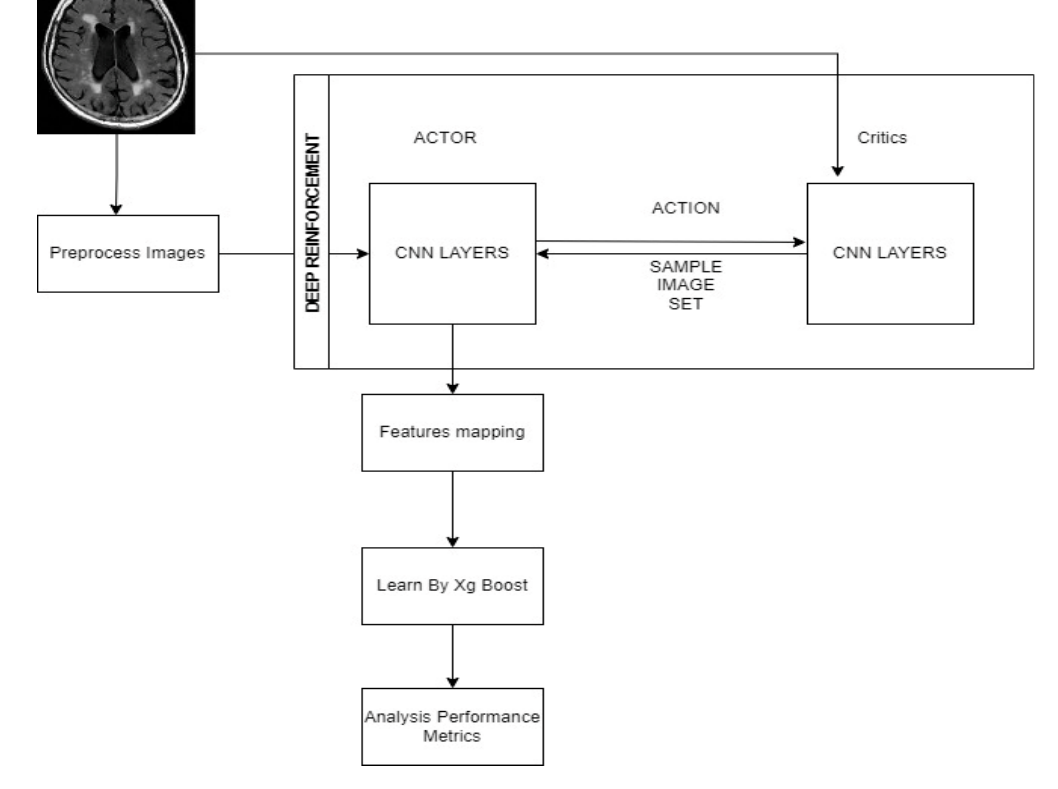
Figure 1. Proposed work architecture.